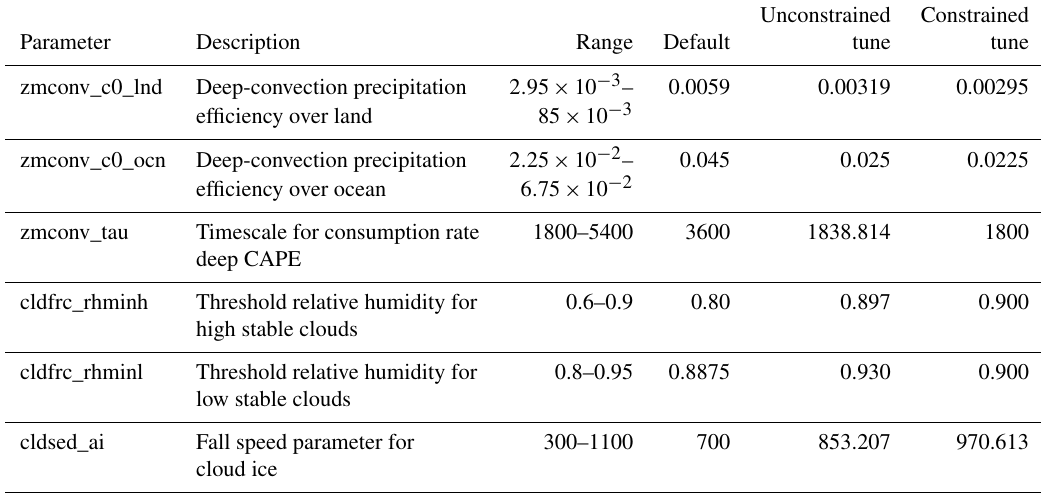
Table 1. Parameters description of CAM5. The default, final optimal values by constrained and unconstrained calibrations, as well as the ranges of parameters. CAPE means the convective available potential energy.